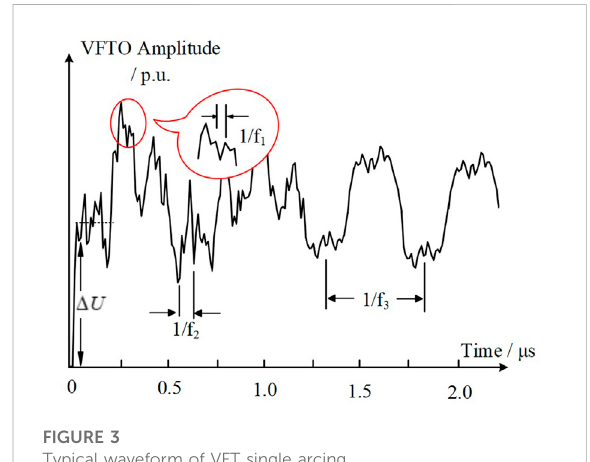
FIGURE 3 Typical waveform of VFT single arcing.